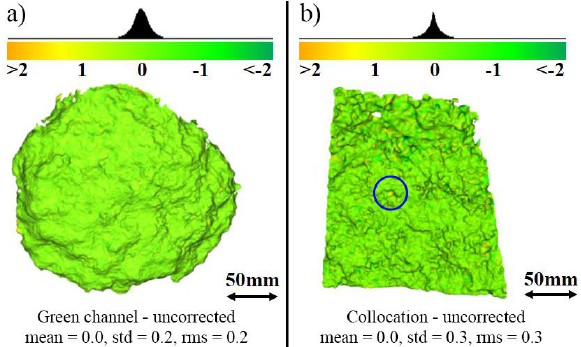
Figure 11. Comparison of point clouds generated by repeating the dense image matching procedure for a) the selected coral, and b) the ocean floor. The blue circle in b) highlights an area where deviations in the order of 1 mm can be observed.